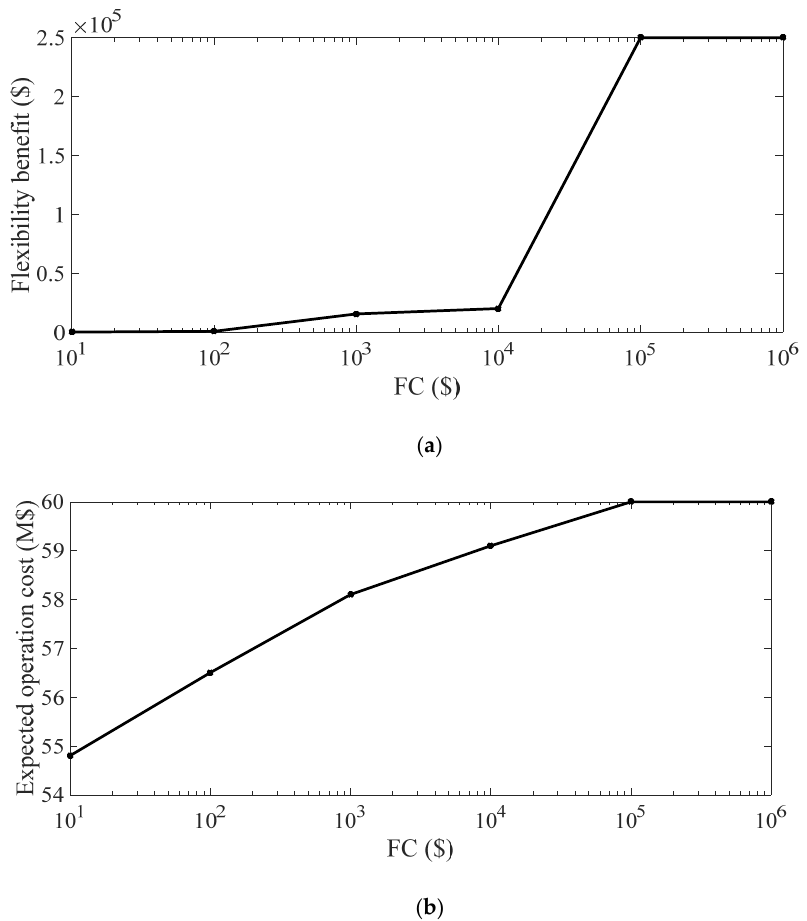
Figure 7. Energy profile of energy storage systems (ESSs).